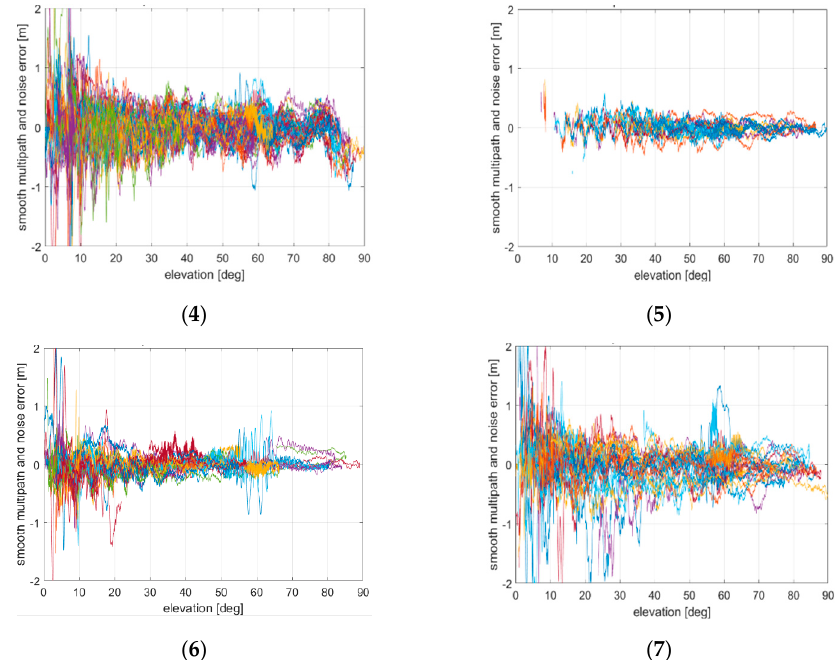
Figure A13. The 100 s smoothed multipath (estimated through CMC) at L1/E1 for the antennas measured at DLR; from left to right, from top to bottom: ( 1 ) Leica AR25 R4; ( 2 ) Novatel GNSS-750; ( 3 ) Javad RingAnt-DM; ( 4 ) Space Engineering GalExpAnt; ( 5 ) DLR internal design; ( 6 ) Navxperience Nav3G+C; ( 7 ) Tallysman VSE6028 VeroStar. Different colors indicate different PRNs.